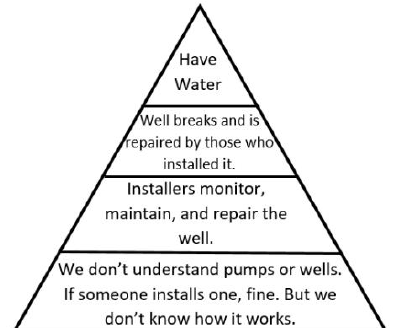
Fig. 34. Ayolé Iceberg model—Villagers'